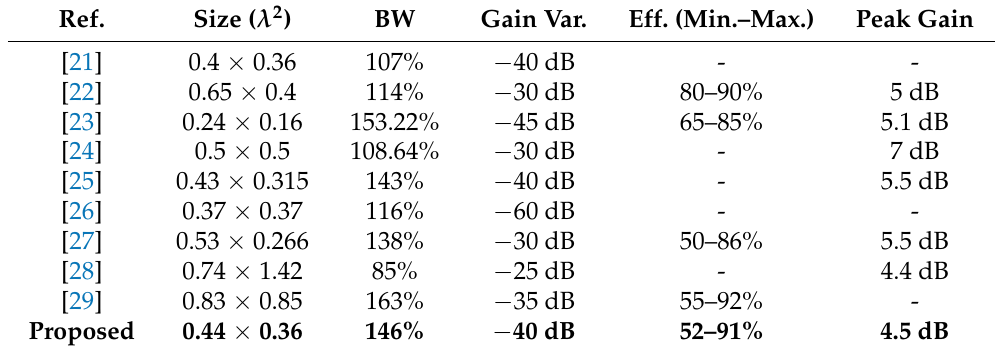
Table 2. Comparison of proposed antenna with existing